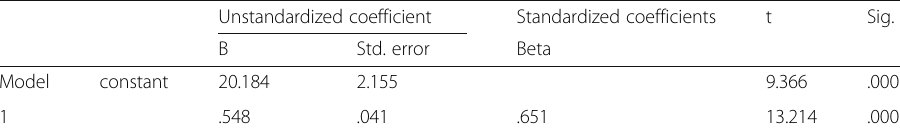
Table 6 Coefficients of predictor and dependent